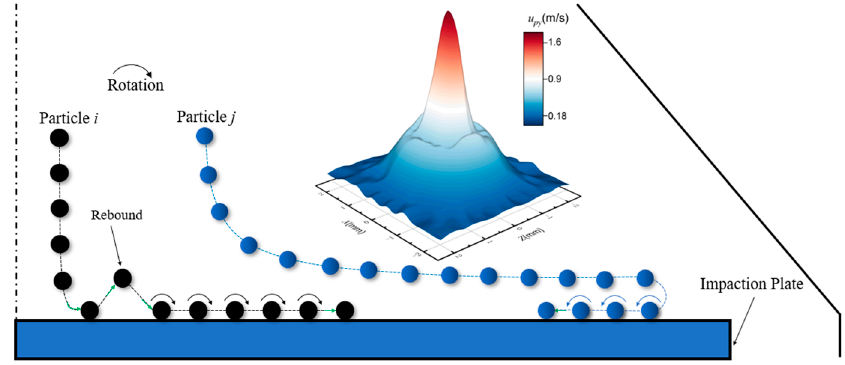
Figure 5. The schematic of particle trajectory above the impaction plate for “halo”.